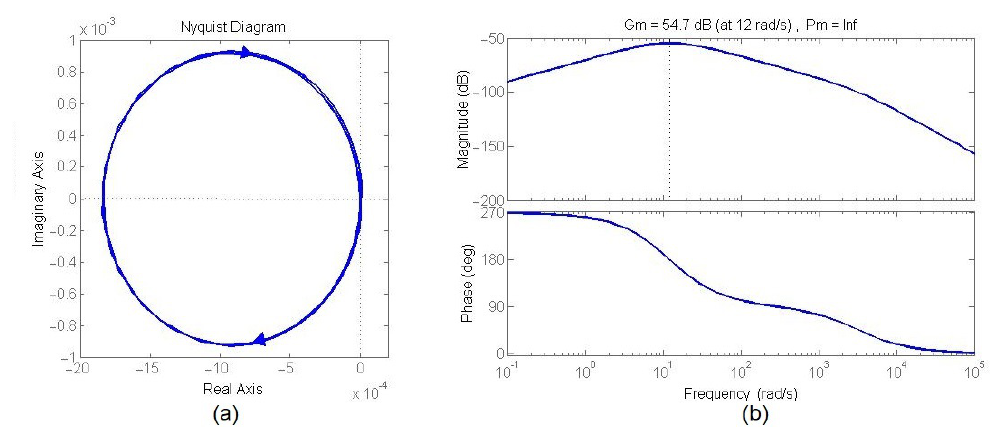
Figure 16. ( a ) Nyquist plot and ( b ) Bode diagrams of F ( s ) H ( s )